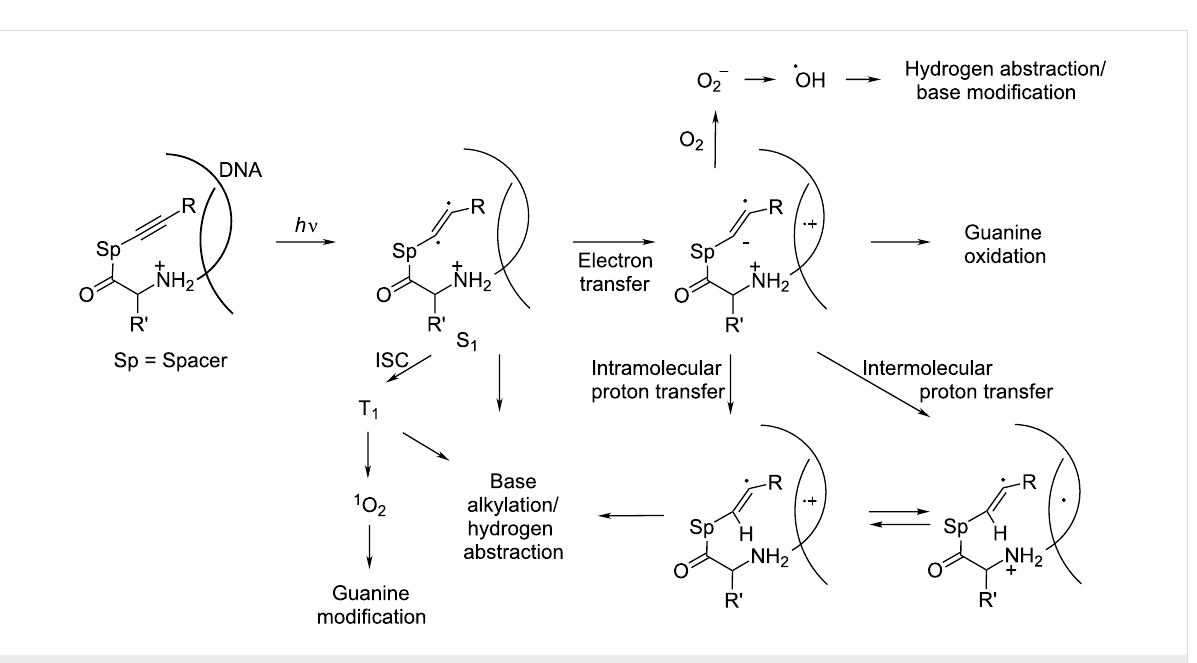
Figure 3: Summary of possible mechanistic alternatives for the observed DNA cleavage by monoacetylene conjugate 1